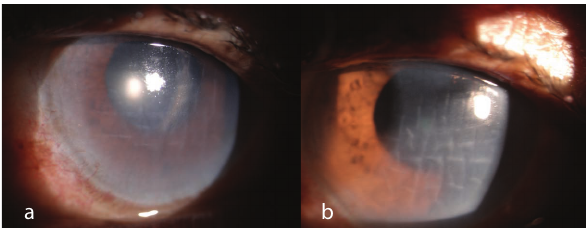
Figure 2. (a) Slit lamp photograph of a patient after exposure to the juice of datura leaves showing corneal edema and folds in the Descemet’s membrane. (b) Slit lamp photograph showing persistent folds in Descemet’s membrane at six months of follow